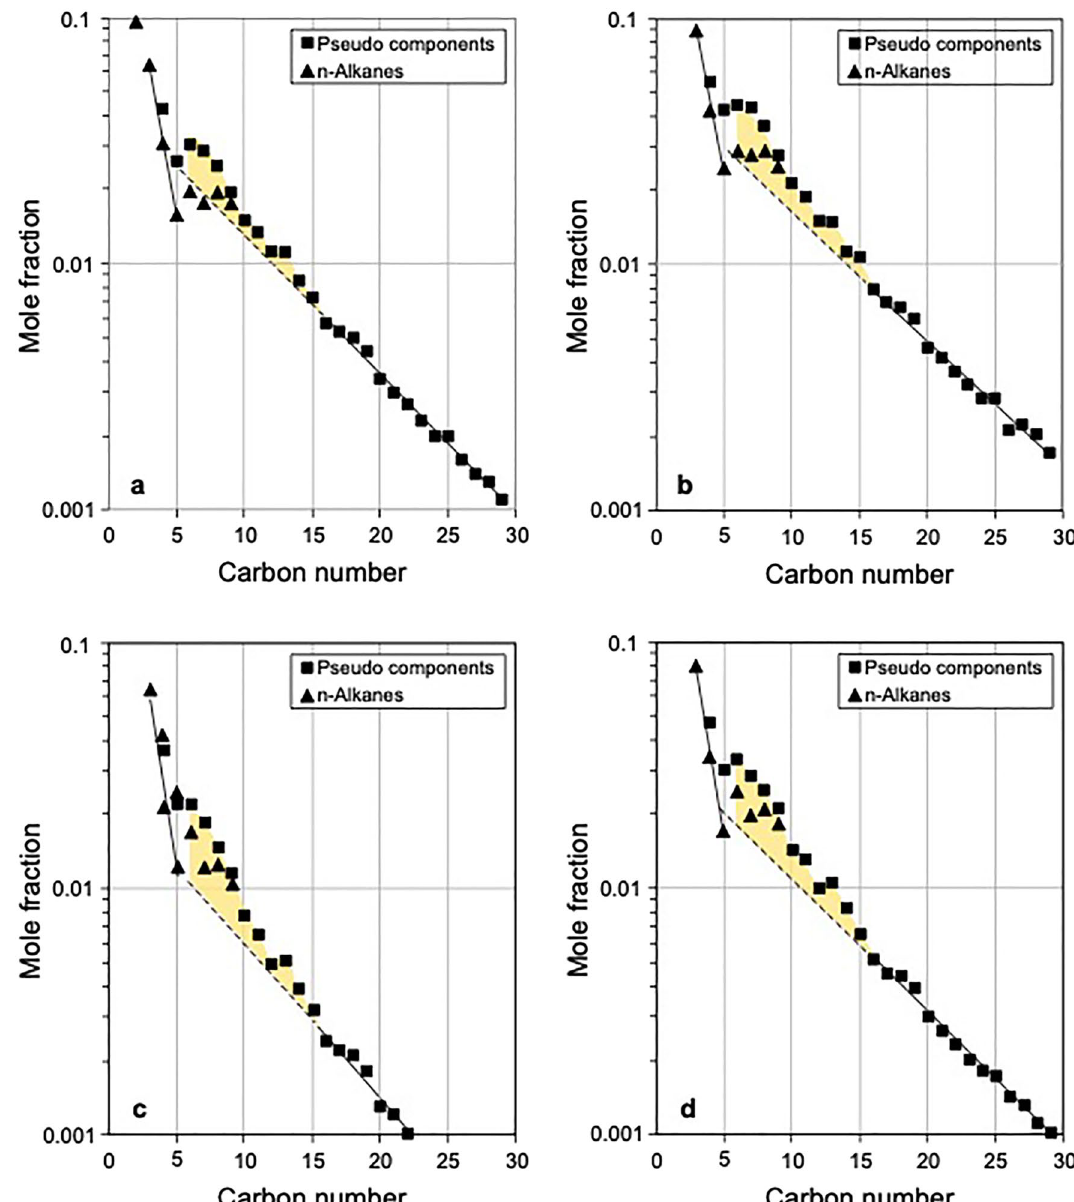
Figure 6. Carbon number vs. mole fraction plots for four Montney wells with recombination PVT data. ( a ) Well 100/16-23-081-18W6/00, Tower area. ( b ) Well 100/12–04-082-18W6/02, Tower area. ( c ) Well 200/A-006- D/094-A-13/02, North Montney area. ( d ) Well 100/07-35-086-23W6/02, North Montney area. Dashed lines indicate projections of C 16+ trends to lower carbon numbers, and show the hypothetical compositions of original oils prior to subsequent modification of the lighter components 1,2 . The molar concentration profiles all exhibit higher concentrations of pseudo-components in the C 6 –C 15 gas-condensate range than expected for unmodified original oils (orange shading), and are interpreted to signify mixing of in-situ oil (C 16+ range) and migrated high-maturity gas-condensate (C 1 –C 15 range) 1,2